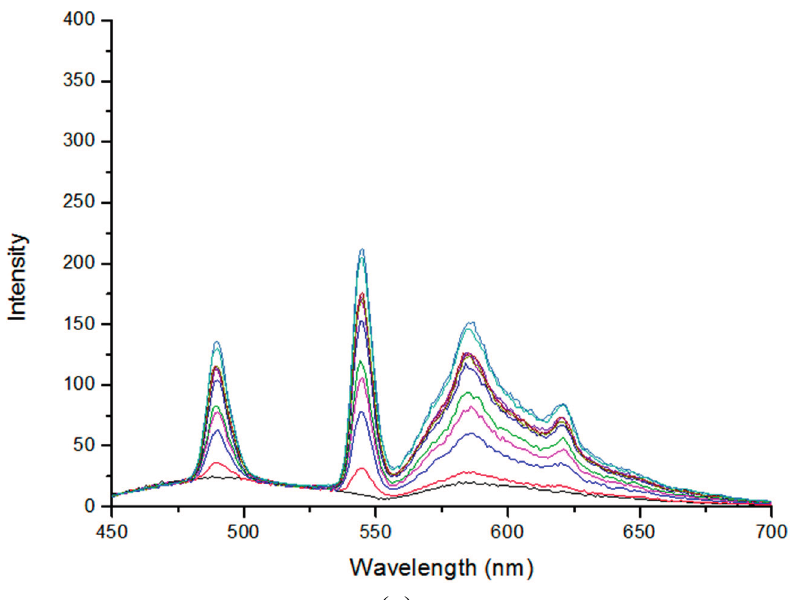
Figure 4. Overlay of absorption and fluorescence spectra of the Tb 3+ -TBP-19-TagRFP sensor. The absorption spectrum is shown by the blue line, the original spectrum of the fluorescence is shown by the black line, and the corrected fluorescence spectrum is shown by the red